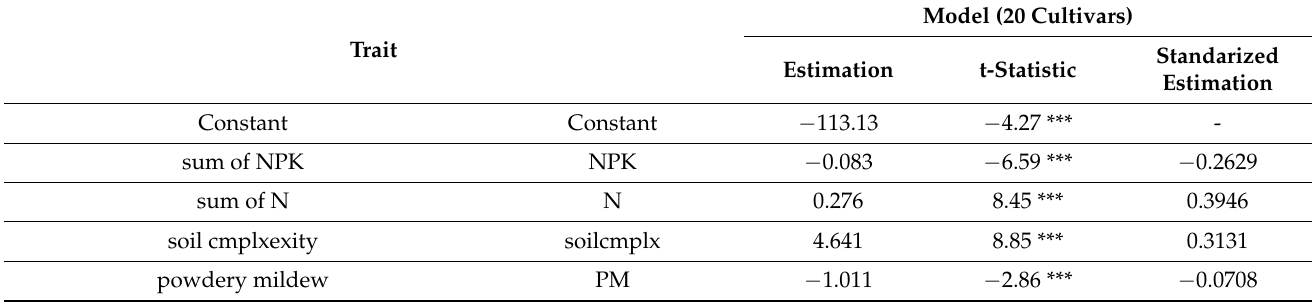
Table 5. Regression model for spring barley yield prediction (AGRO_SBY) for whole group of the twenty barley varieties based on the data collected in thirteen locations including genetic potential, environment, and management traits under moderate input management